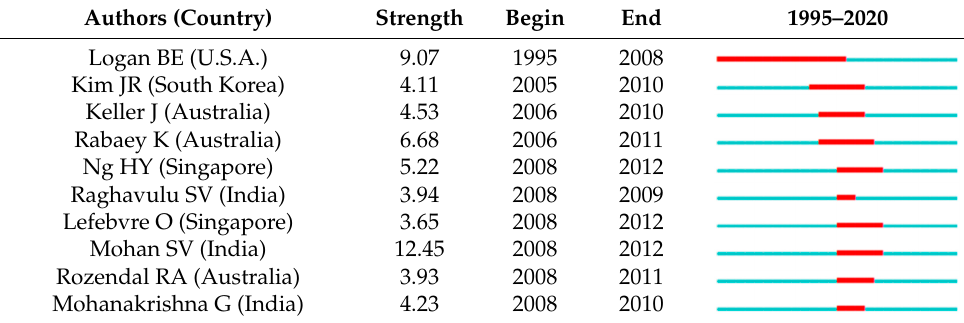
Table 11. The top 10 authors with bursts.